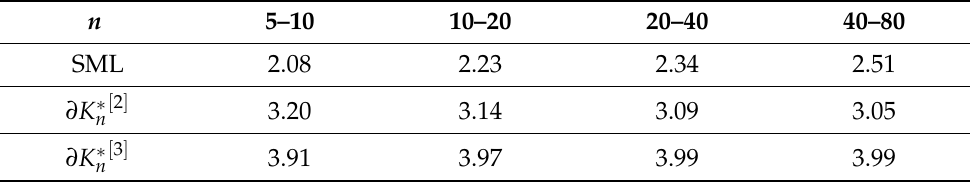
Figure 4. Semilinear equation with f ( t , u ) = uu x + h ( t ) and GRK4T integrator, with Dirichlet boundary conditions. Table 4. Orders for global error, GRK4T and f ( t , u ) = uu x + h ( t ) . SML stands for ‘standard method of lines’ and ∂ K ∗ n [ 2 ] , ∂ K ∗ n [ 3 ] for the different variations of the technique suggested in this